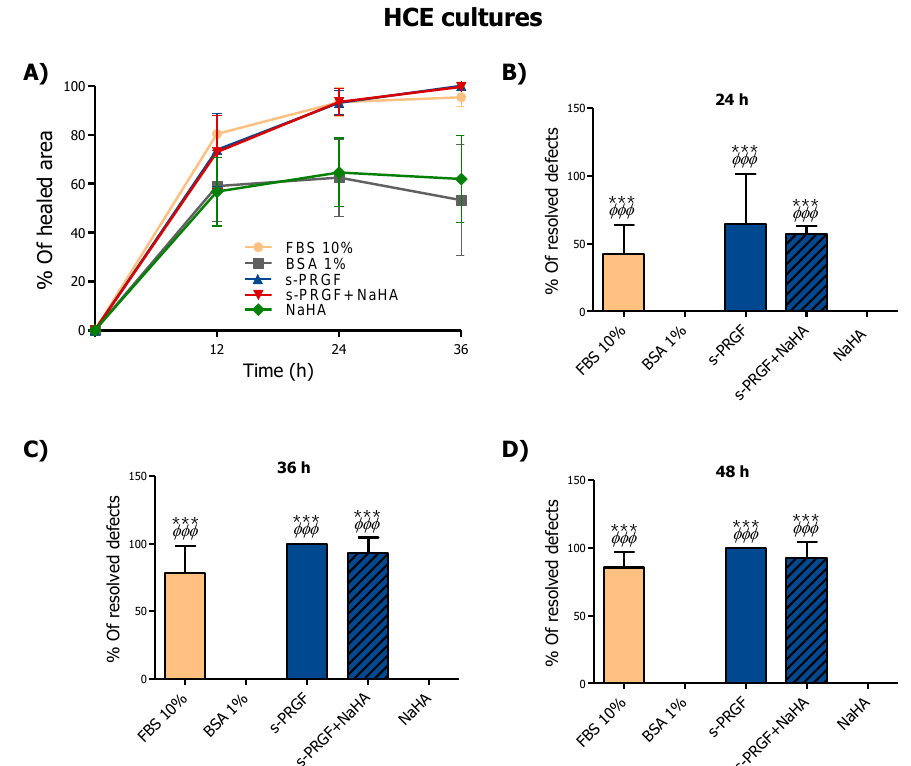
Figure 4. Effect of s-PRGF, alone or combined with NaHA, on the re-epithelialization of human corneal epithelial (HCE) cells ( A ). Cultures were exposed for 72 h to 10% FBS; 45% s-PRGF; 45% s-PRGF + 0.1% NaHA (combined treatment); 0.1% NaHA; and 1% BSA as a negative control. The percentage of re-epithelialized area of HCE cultures after 36 hr ( A ), and percentage of wells in which the defect in the monolayer had completely resolved at 24 ( B ), 36 ( C ) and 48 ( D ) hours are shown. Statistically significant differences with respect to BSA (*) or NaHA ( Φ ) (*** p < 0.001; ΦΦΦ p < 0.001; n/s, not significant. χ 2 test and Fisher’s exact